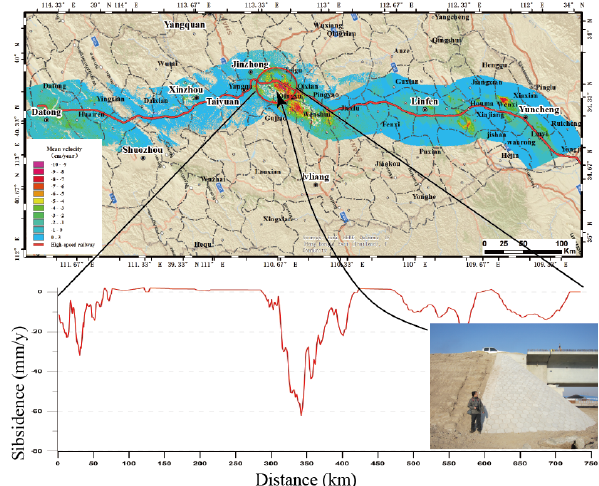
Figure 3. Deformation map along Datong-Yuncheng high speed railway (HSR). Insets are land subsidence profile in Qixian county and field photo of joint of bridge and foundation of HSR under con- struction.